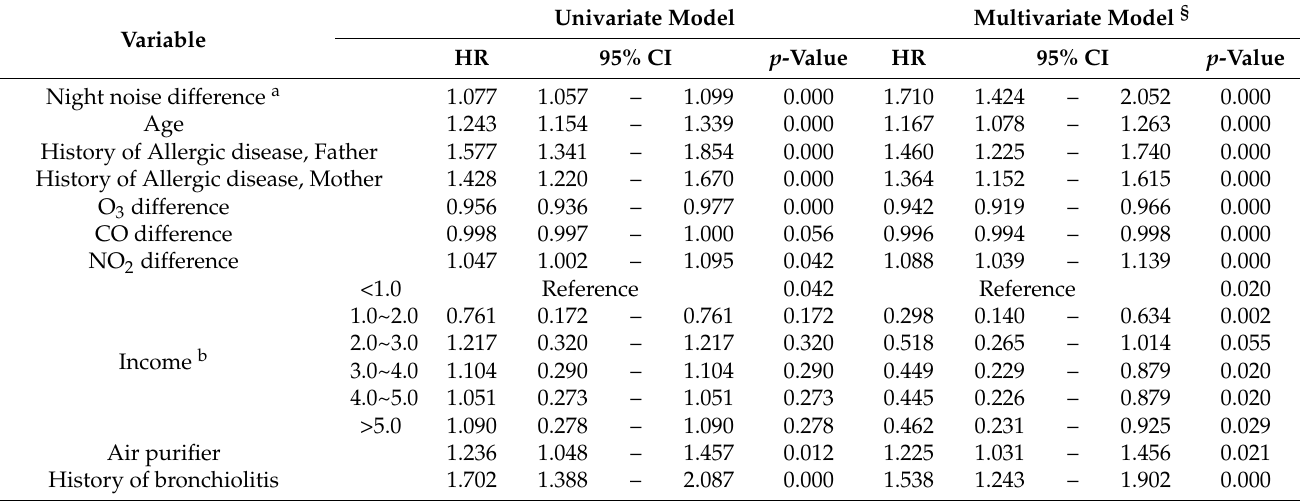
Table 4. Association between night-noise difference and incidence of allergic disease.